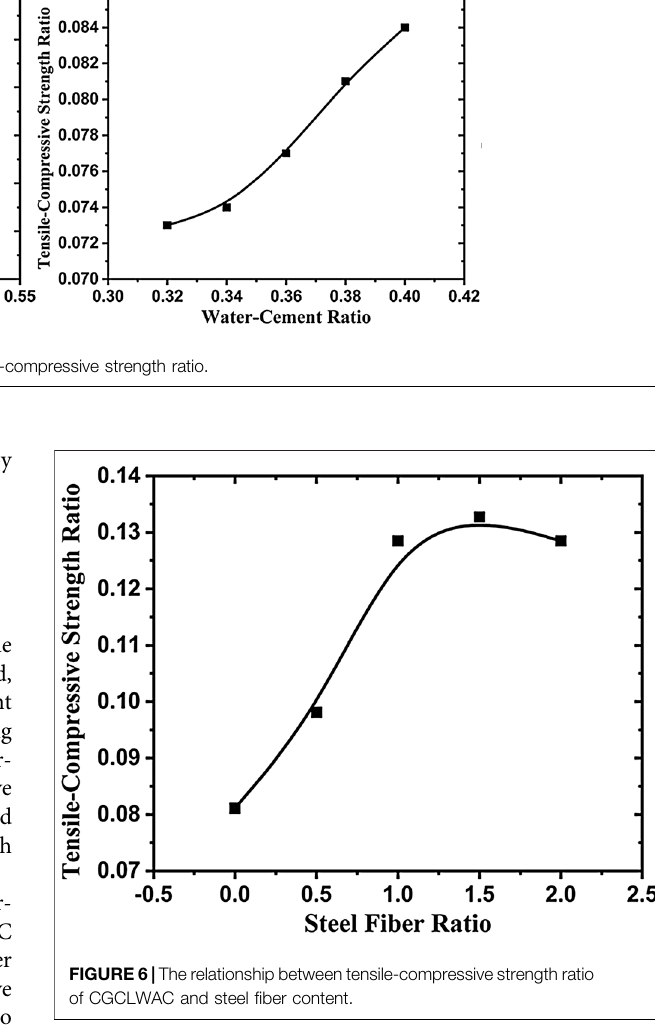
Frontiers in Materials |